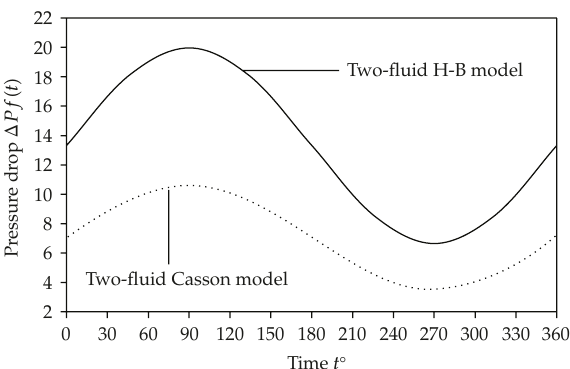
Figure 2: Variation of pressure drop in a time cycle of the two-fluid Casson and H-B models.